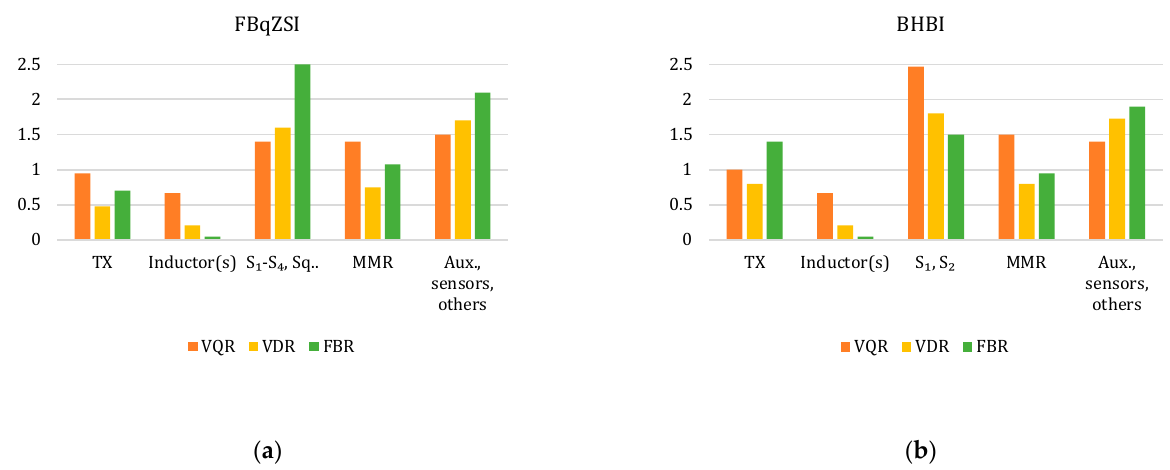
Figure 14. Power loss breakdown calculated at 100 W for operating voltages from Figure 11 considering two BFEIs: ( a ) FBqZSI and ( b ) BHBI.